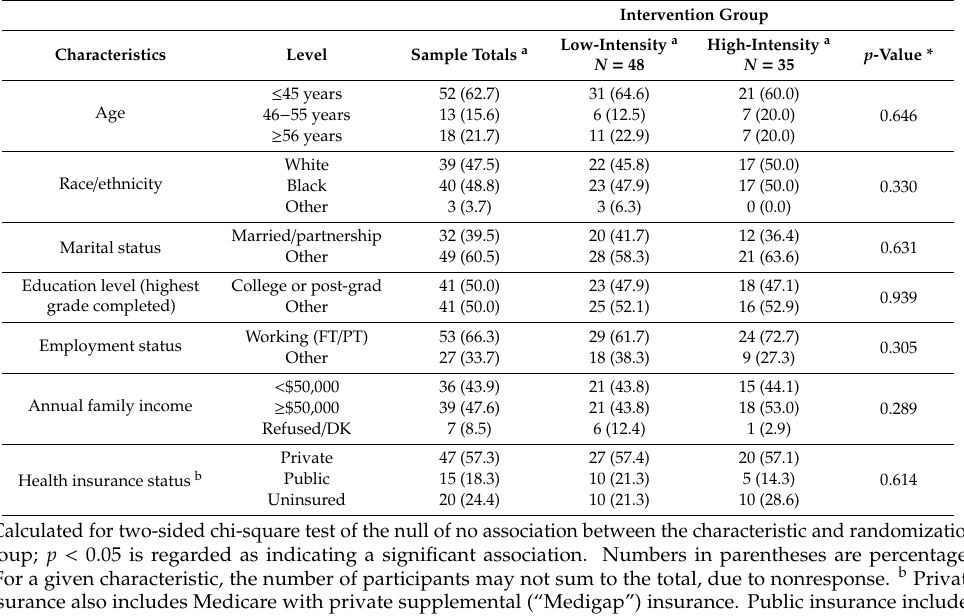
Table 2. Sociodemographic characteristics among first-degree relatives (FDRs) of high-risk breast cancer survivors by randomized screening interventions.